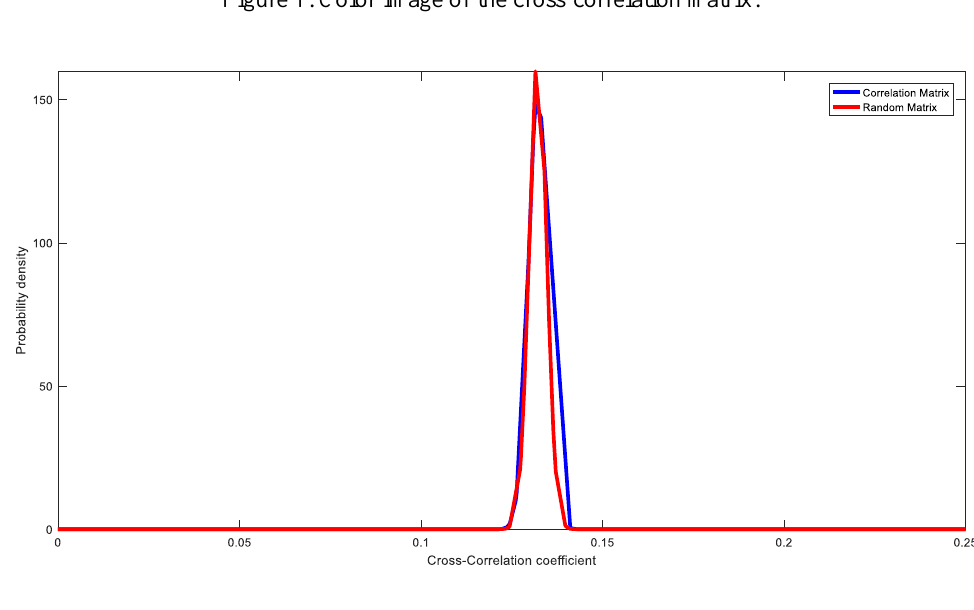
Figure 2. comparing the distribution of correlation coefficients of random matrix and real matrix for active banks in